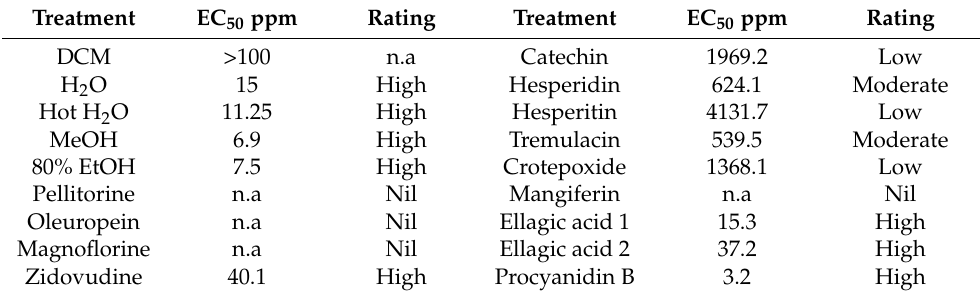
Table 2. EC 50 values for compounds and extracts (treatment group) against the HIV-1 reverse transcription process. A high rating is for values <100 ppm, whereas moderate is 100–1000 ppm. Low activity is above this value. Nil is for no activity detected.